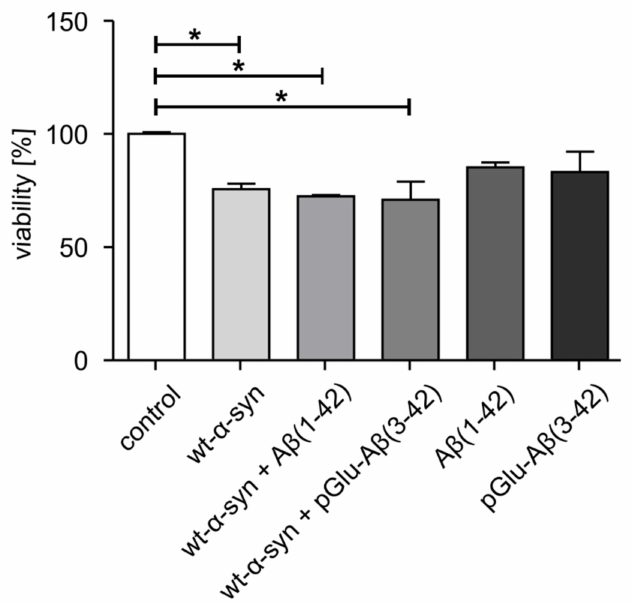
Figure 6. Analysis of cellular toxicity of aggregates of wt- α -synuclein (40 µ M) in the presence or absence of 1 µ M A β (1–42) or 1 µ M pGlu-A β (3–42). Cell viability was assessed by MTT assay in mouse primary neurons after 72 h of treatment with the peptides (mean ± SD, n = 6, * p ≤ 0.05, one-way ANOVA followed by Tukey post-hoc